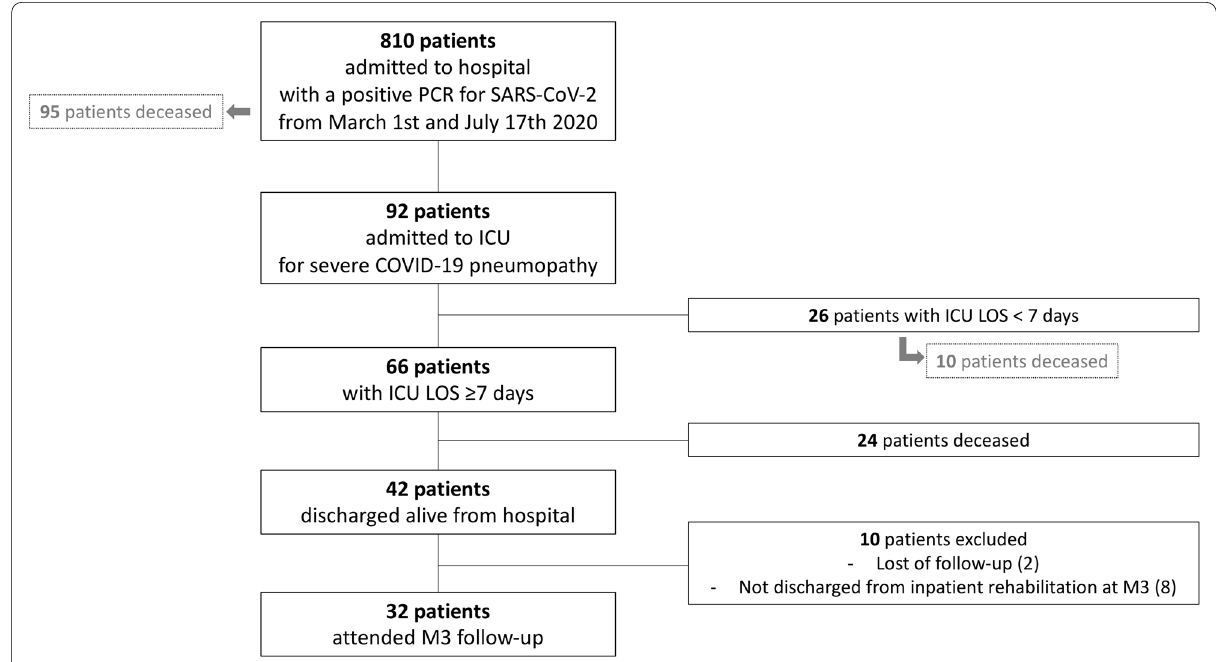
Fig. 1 Flowchart. ICU intensive care unit, LOS length of stay, PCR polymerase chain